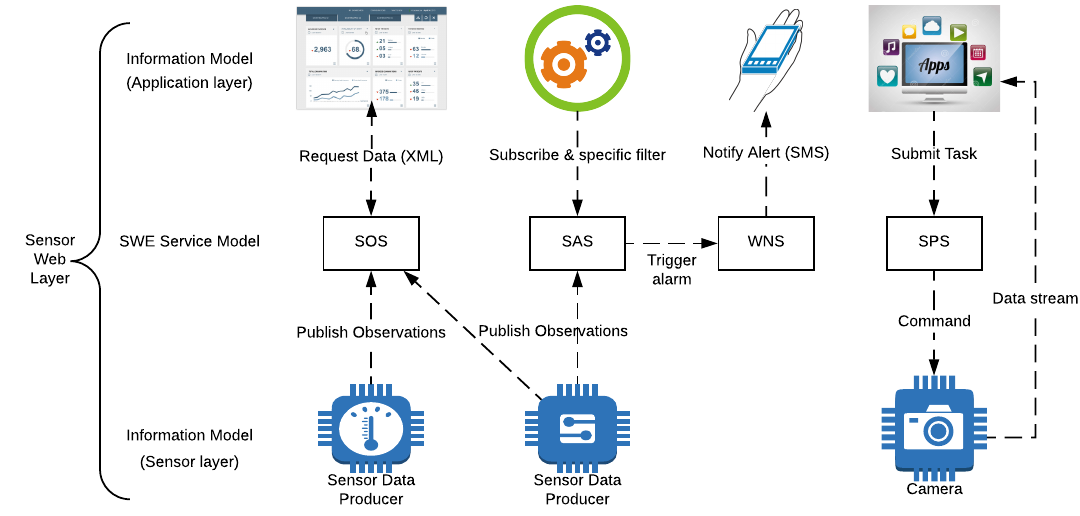
Figure 3. Example of Open Geospatial Consortium–Sensor Web Enablement (OGC-SWE)